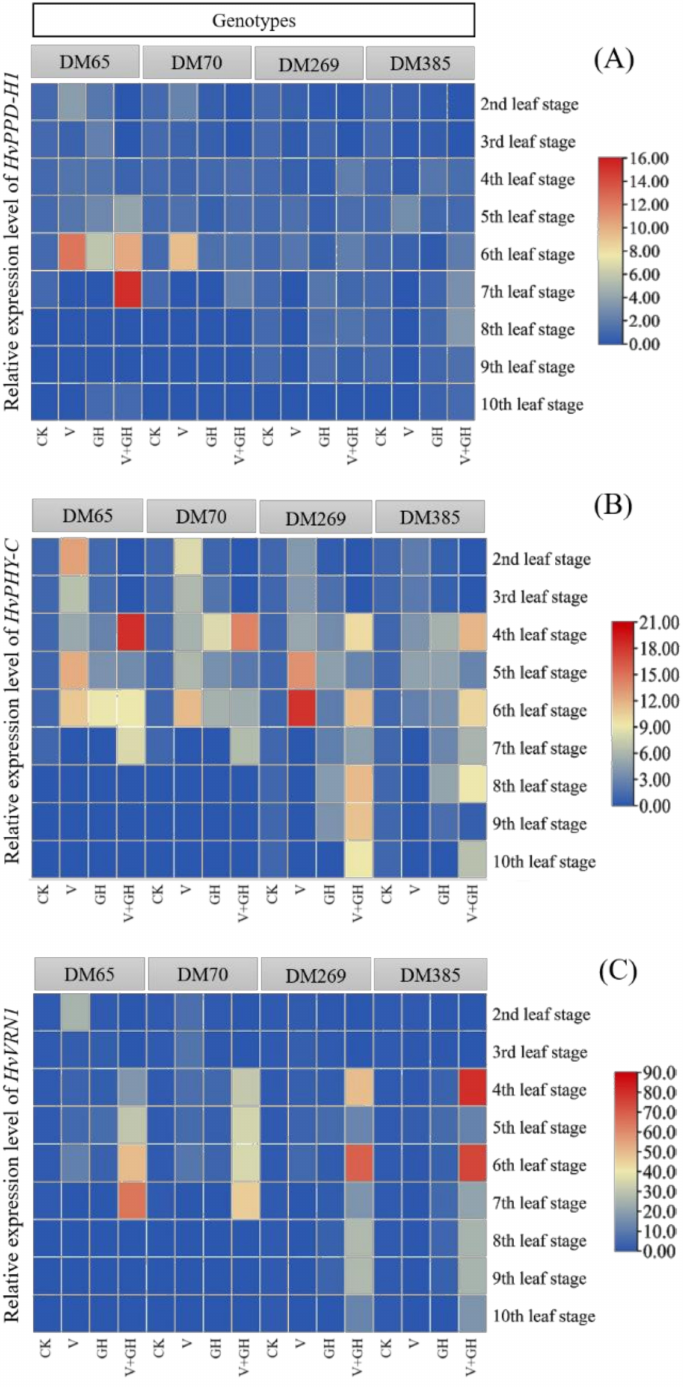
Figure 4. Heat map representing the relative expression of candidate genes involved in barley heading date ( n = 5). ( A ) HvPPD-H1 , ( B ) HvPHY-C , and ( C ) HvVRN1 . Legends: control (CK), vernalization (V), greenhouse (GH), and moved to the greenhouse post-vernalization (V + GH). The gene expression intensity spanned from low (blue) to high (red). The expression values have been calculated as fold